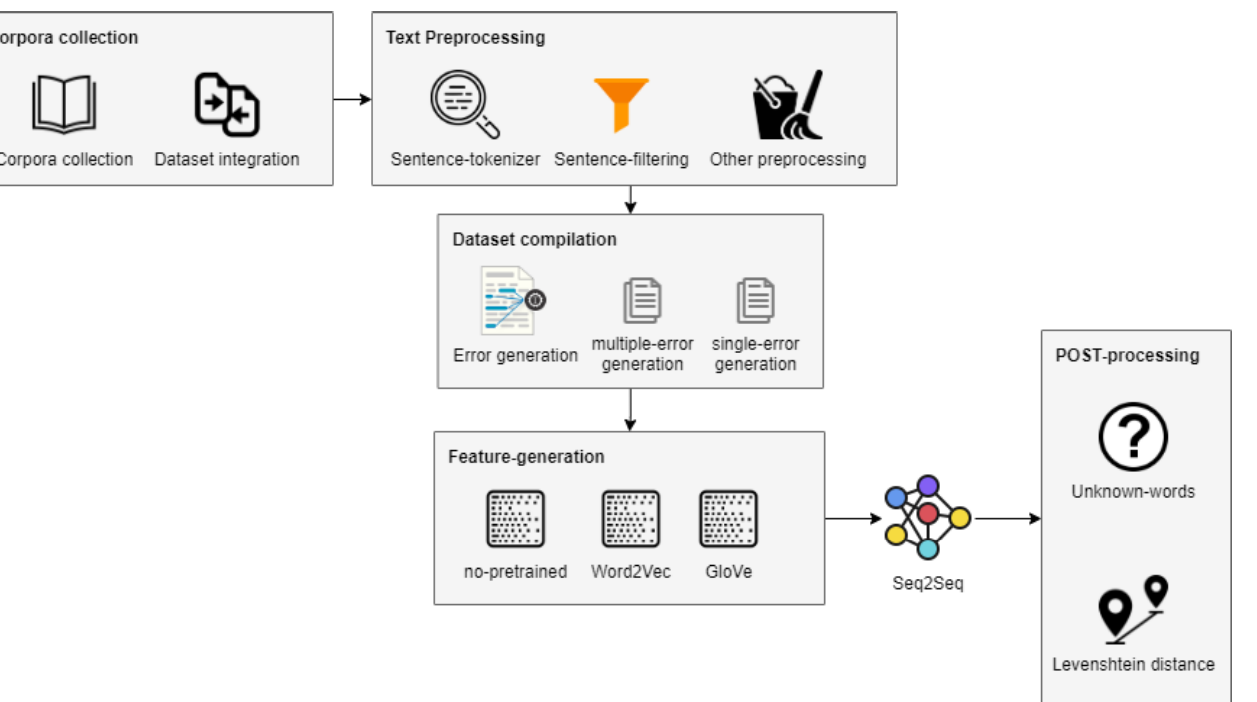
Figure 1. Block diagram of the seq2seq-based approach to clinical texts correction.